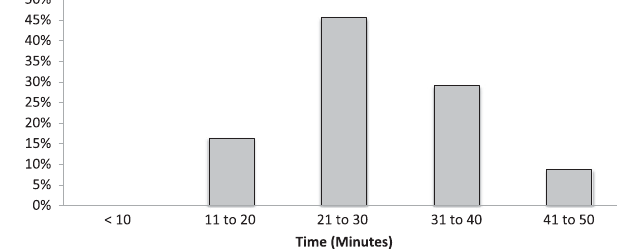
FIG. 2. Histogram of CURrENT completion times for a subset of 79 students at CU